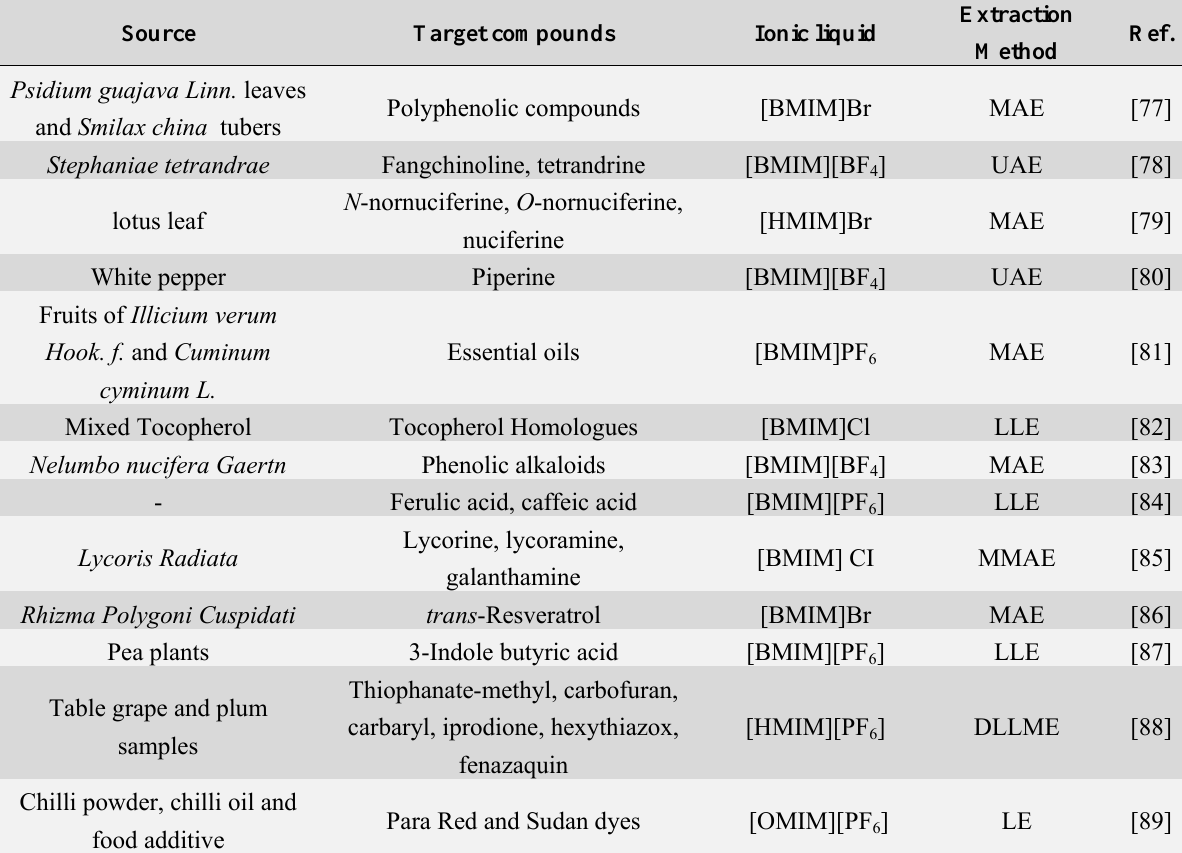
Table 4. Extraction of bioactive compounds from natural plant.